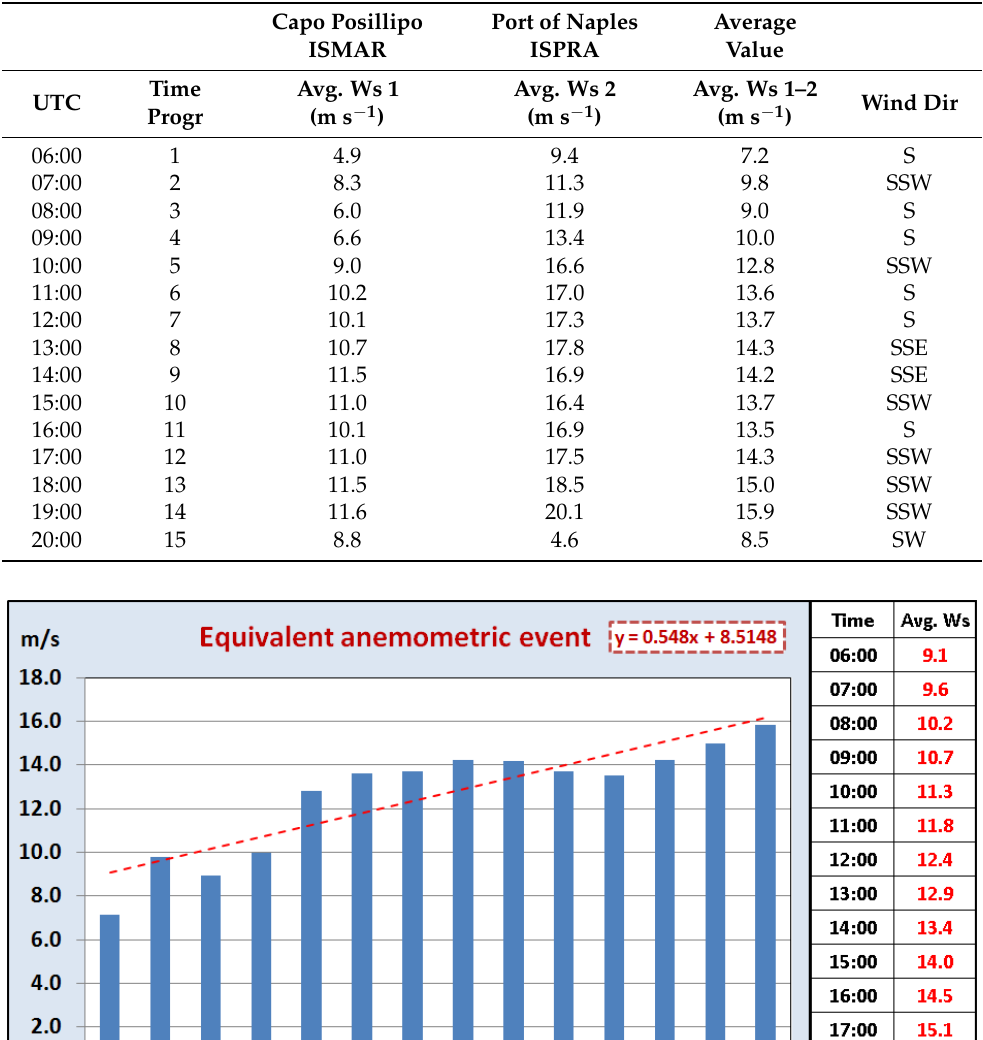
Table 6. Wind event as sequence of hourly average wind speed at Capo Posillipo (ISMAR) and Port of Naples (ISPRA) weather stations. Data are in reference to 28 December 2020.